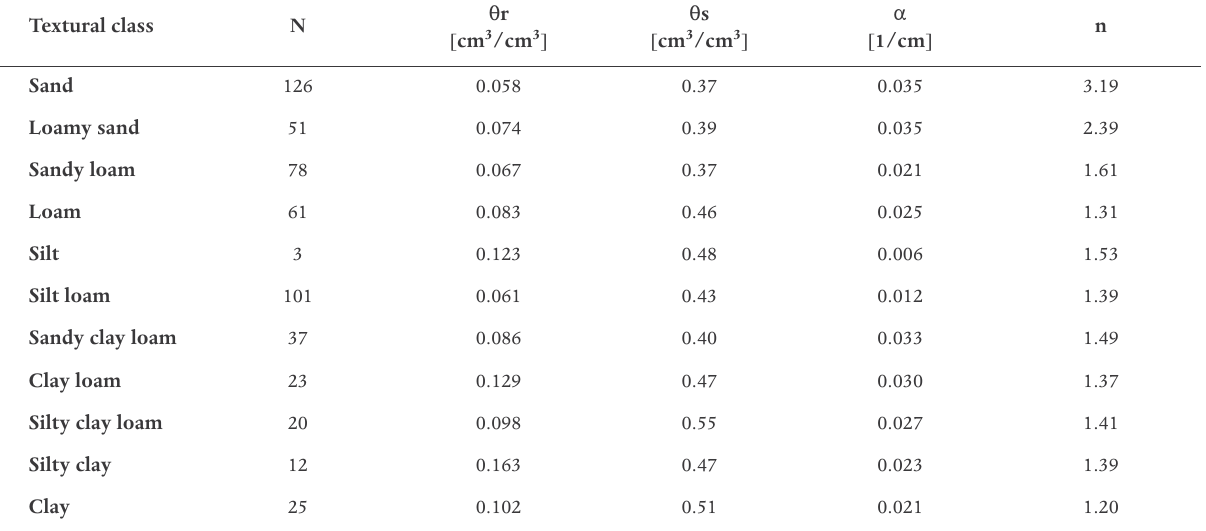
Table 1. Typical van Genuchten model with parameters ( a , n ) including residual ( i r ) and saturated ( i s